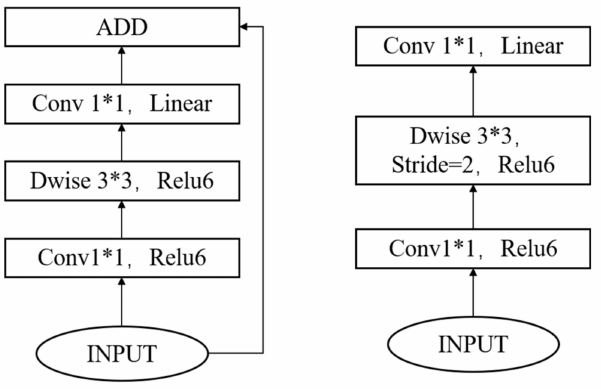
Figure 5. Bottleneck depth-separable convolution